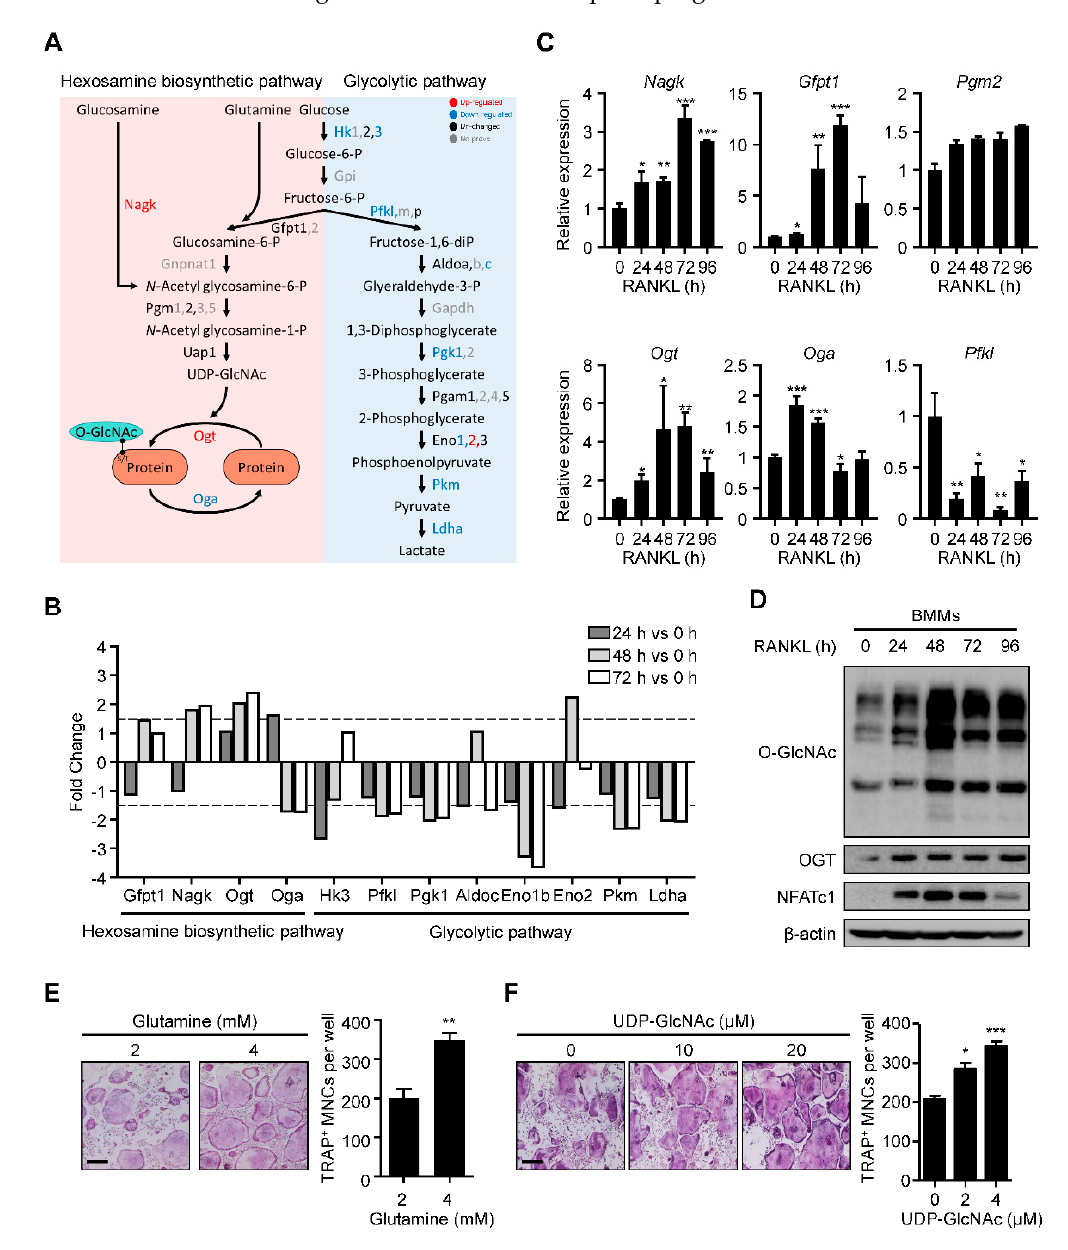
Figure 1. O-GlcNAcylation is required for RANKL-mediated osteoclast differentiation. ( A ) The transciptome data (GSE176265) showed relative mRNA expression levels of the glycolytic pathway and HBP during osteoclast differentiation. ( B ) The fold changes of the HBP and glycolytic pathway genes are illustrated on a graph. Dotted lines represent 1.5-fold differences. ( C ) Relative mRNA expression levels of HBP during osteoclast differentiation, as measured by RT-qPCR. ( D ) The RANKL-induced global O-GlcNAcylated protein and Ogt protein levels, as confirmed by Western blot analysis. ( E ) High amounts of glutamine (4 mM) increased the TRAP-positive multinuclear cells compared with low amounts of glutamine (2 mM). The TRAP-specific mature osteoclasts were counted (left panel). Scale bar, 200 μ m. ( F ) High amounts of UDP-GlcNAc, the end product of HBP, increased the TRAP-specific mature osteoclasts compared with the control culture. The TRAP-specific mature osteoclasts were counted (left panel). Scale bar, 200 μ m. Statistical data are presented as the means ± S.E.M. (* p < 0.05, ** p < 0.01 and *** p < 0.001, as measured by Student’s t -test).